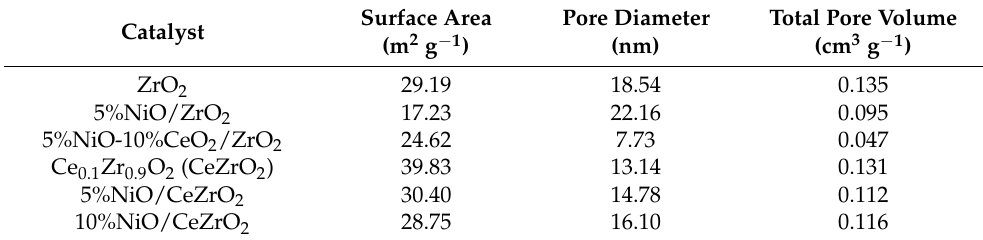
Table 1. Physical property of ceria-zirconia-supported nickel catalyst.